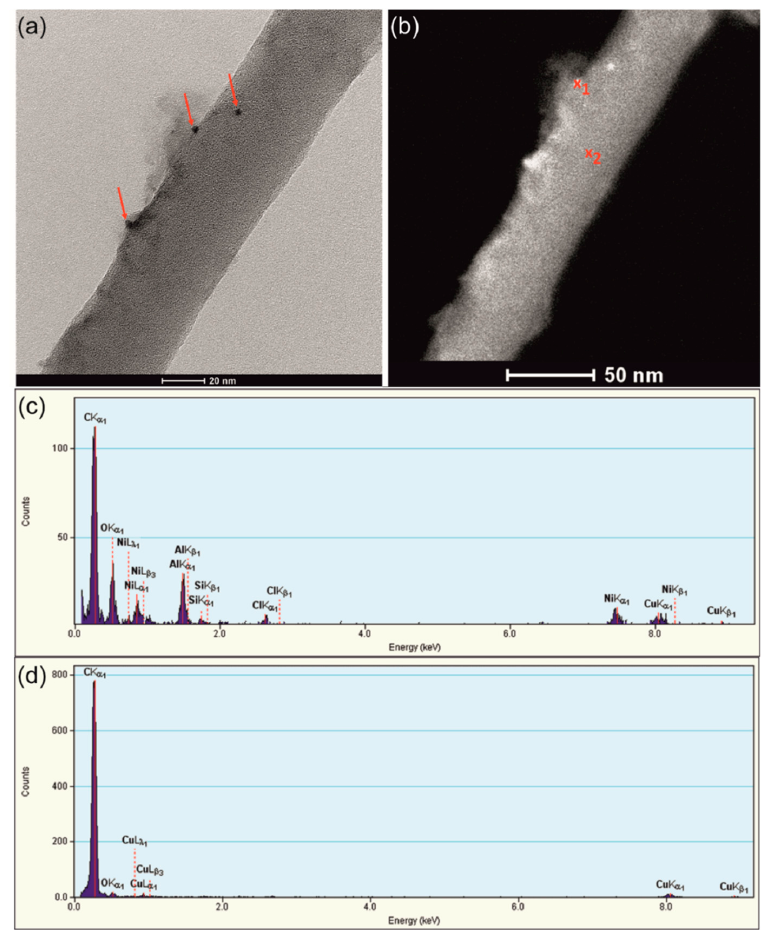
Figure 5. BFTEM image of the single hybrid PPy-Ni(OH) 2 nanowire ( a,b ) together with EDS analyses of points marked in figure (b) as x 1 ( c ) and x 2 ( d ).